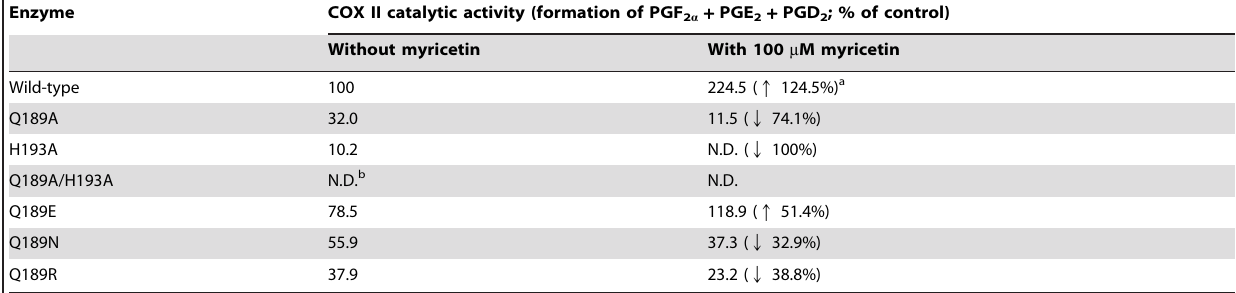
Table 2. The catalytic activity of several COX II mutants assayed in the presence or absence of myricetin.